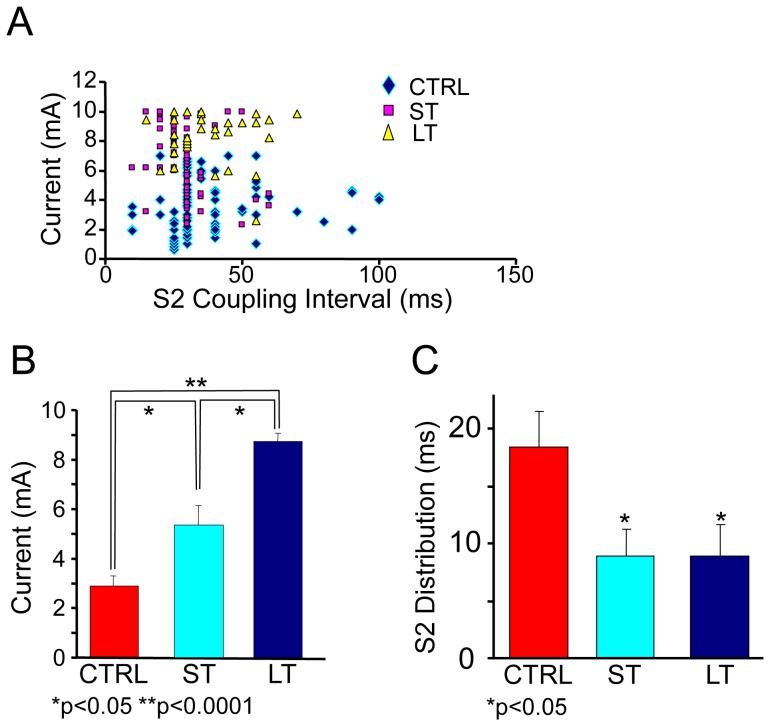
Induction of VF and exercise intensity.A. Current intensity and S2 interval for VF induction in individual experiments for the 3 groups. B. Threshold current for VF induction in the studied groups (p<0.05 for ST compared to LT and CTRL, p<0.0001 for LT compared to CTRL). C. The relationship between the exercise intensity (the different groups) and the distribution of stimulus coupling interval S2 that induces VF in the studied group (ST and LT compared to CTRL).